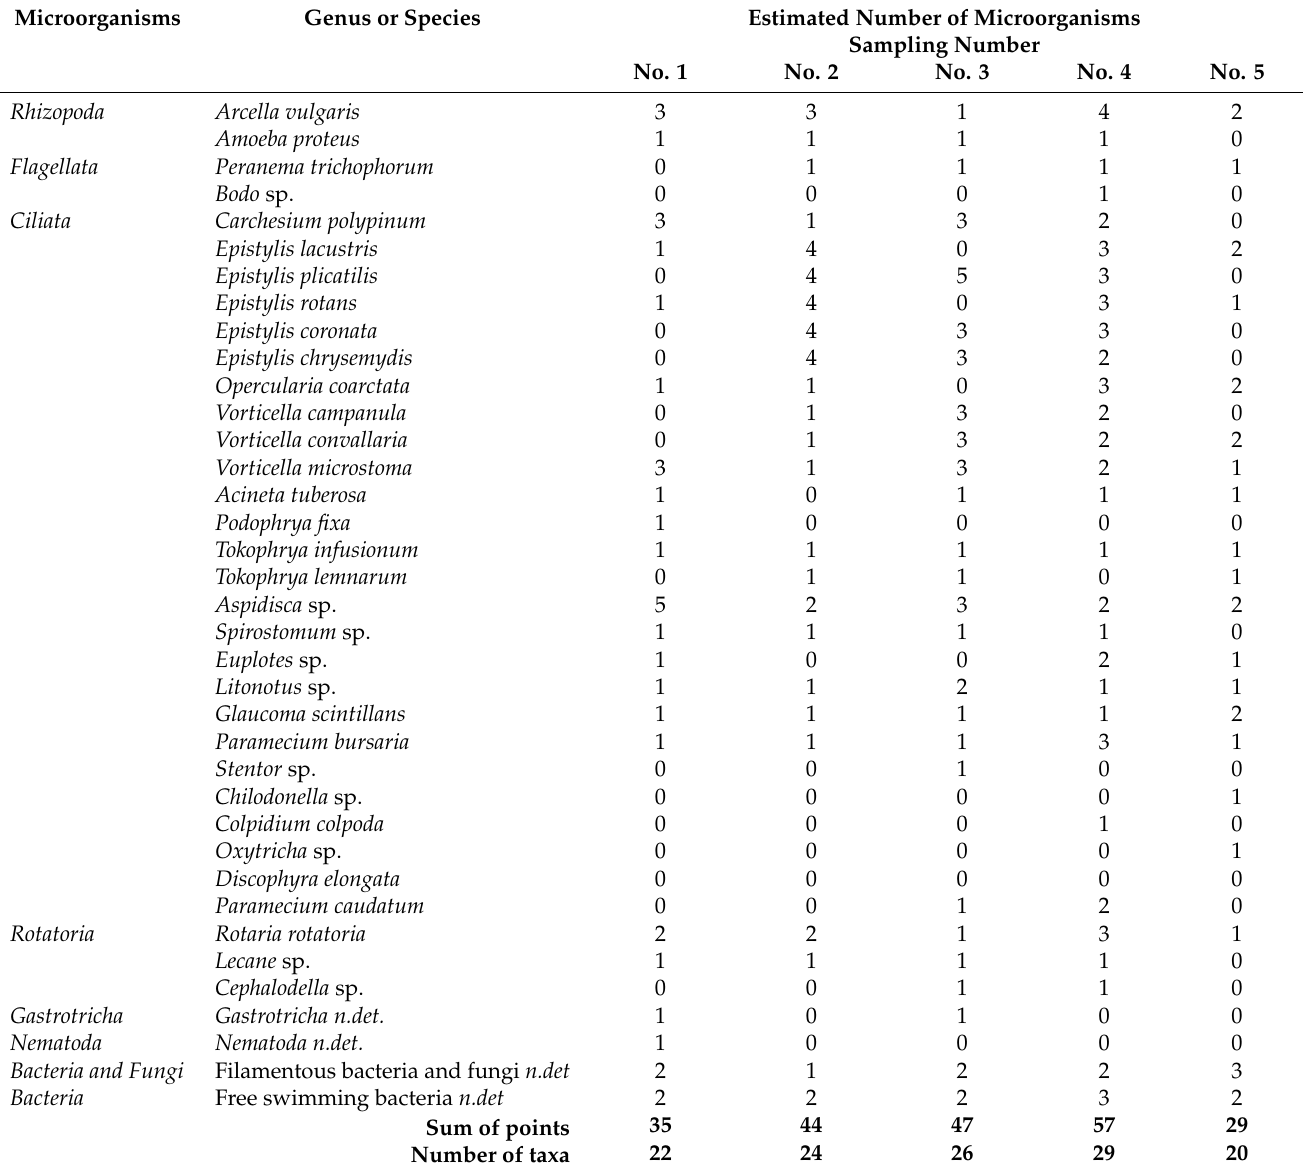
Table 5. Estimated number of microorganisms in activated